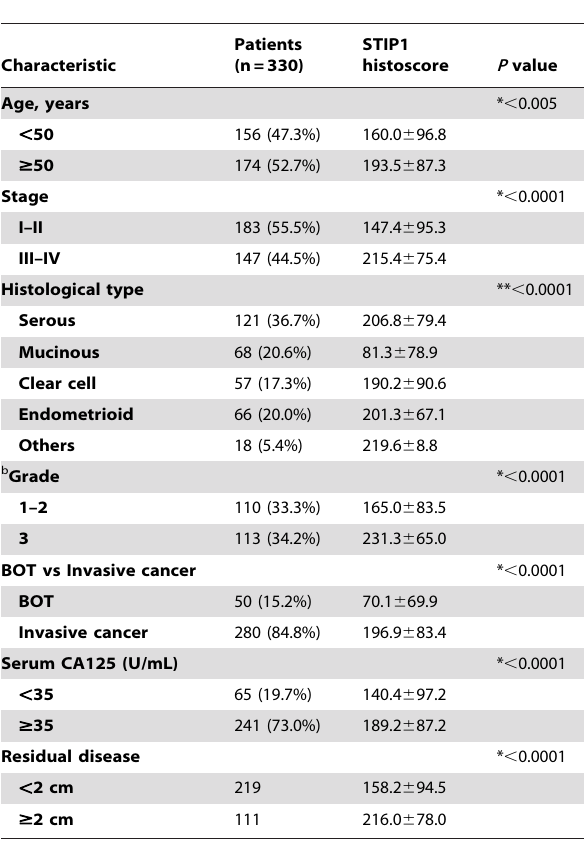
Table 1. Clinicopathological characteristics and STIP1 histoscore a in 330 patients with ovarian